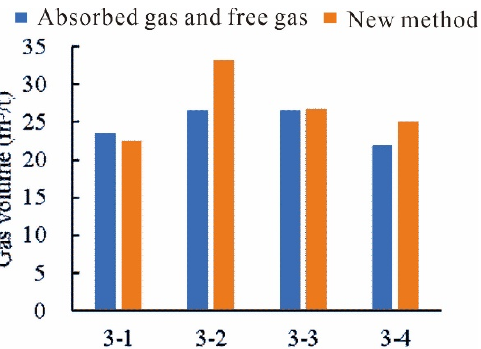
Figure 10. Comparison Between the New Method and the Sum of Adsorbed and Free Gas.